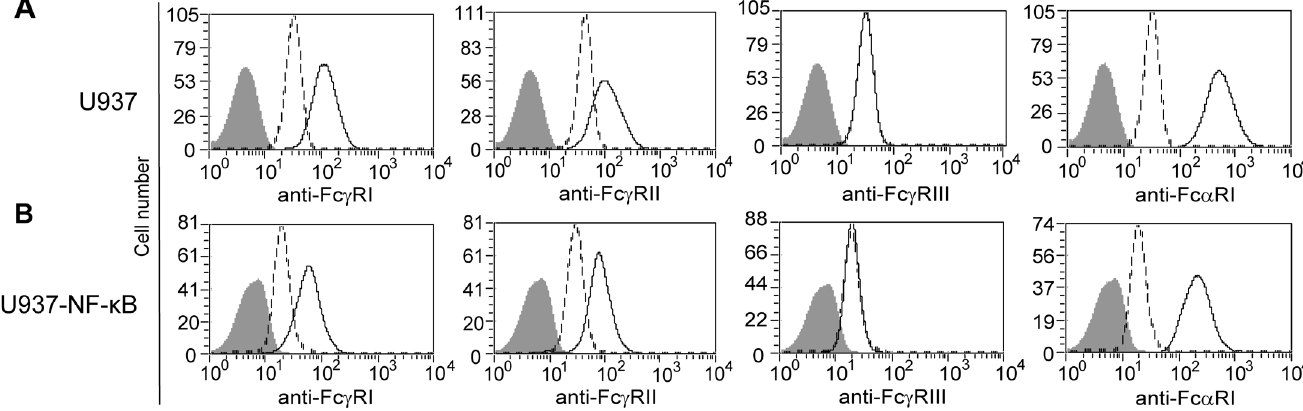
Fig 1. Expression of Ig receptors on the U937-NF- κ B reporter cell line. U937 cells express Fc γ RI, Fc γ RII, Fc α RI of Fc receptors (A). Transfection with NF- κ B-GFP did not alter the Fc receptor expression patterns in the U937 cell line (B). U937 and U937-NF- κ B cells were labeled with PE-conjugated anti-Fc γ RI, Fc γ RII, Fc γ RIII and Fc α RI, antibodies. The histograms show the unlabeled cells (filled histogram), the corresponding isotype control labeled cells (dashed line) and the specific antibody stained cells (solid line).